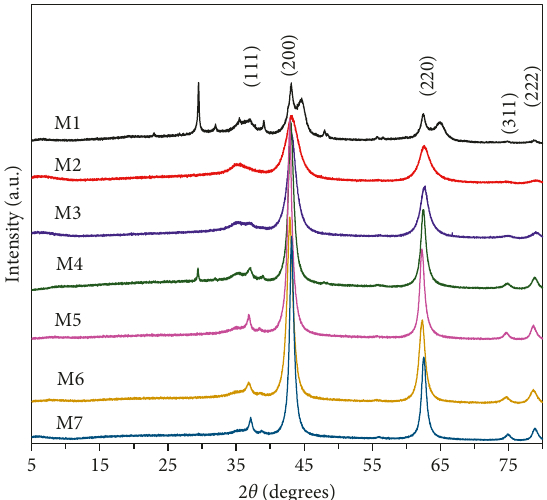
Figure 4: X ray diffraction of Mg/Al hydrotalcites with different Mg/Al ratios activated at 500 ° C before photoreaction.